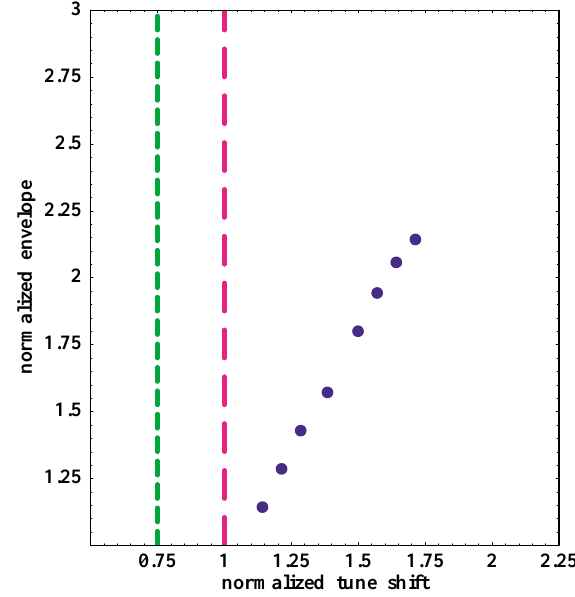
FIG. 7. Vertical (upper red curve) and horizontal (blue curve) rms emittances of a KV beam for ˜ N (cid:1) 9.7 . Increase of vertical emittance due to the 1 (cid:1) 2 coherent resonance.